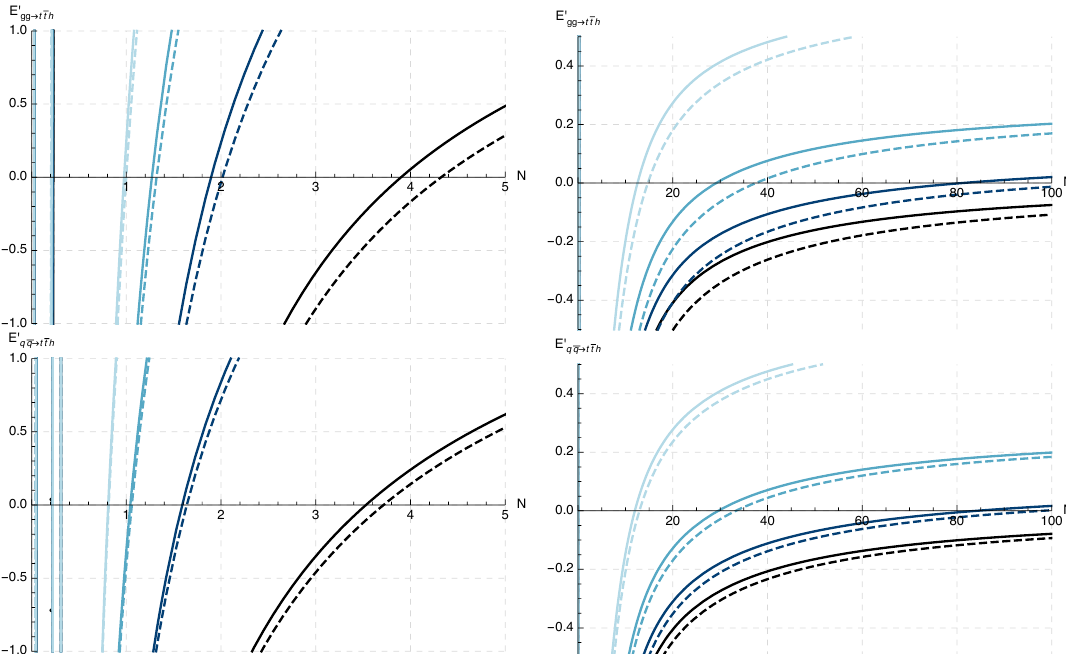
with (solid) and without the g ( n ) contributions (dashed) for the gg / q ¯ q initiated Figure 10 . E 0 ij → t ¯ th process (top/bottom). We set τ/ρ = 0 . 1 (black), 0 . 01 (dark blue), 0 . 001 (blue), 0 . 0001 (lightest blue) for the left panel, while for the right panel we use τ/ρ = 0 . 99 (black), 0 . 9 (dark blue), 0 . 75 (blue), 0 . 5 (lightest